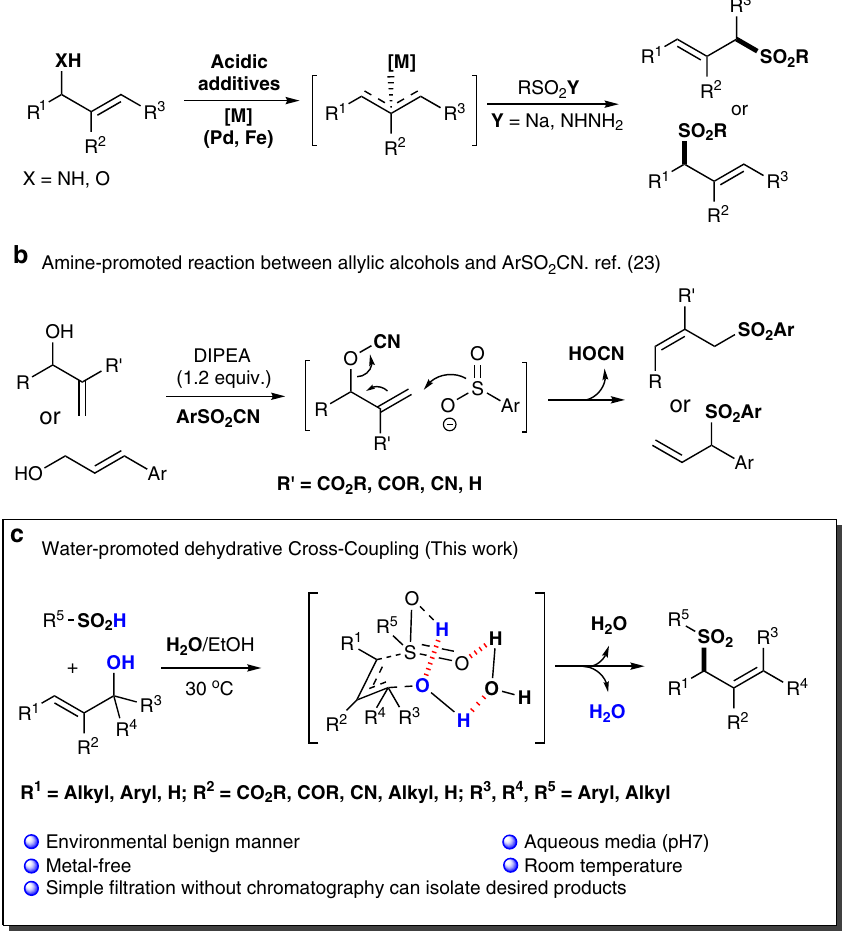
Fig. 2 Strategies for direct sulfonylation of allylic alcohols. a Transition-metal (Pd and Fe)-catalyzed direct substitution of allylic amines and alcohols. Acidic additives (stoichiometric amount of B(OH) 3 /Et 3 B or TMSCl). b Amine (DIPEA: N -ethyl- N -isopropylpropan-2-amine) promoted reaction between allylic alcohols and ArSO 2 CN. c In this report, water-promoted dehydrative cross-coupling reaction. The reaction conducted in an environmental benign manner under physiological conditions (pH 7, aqueous media, metal-free, and room